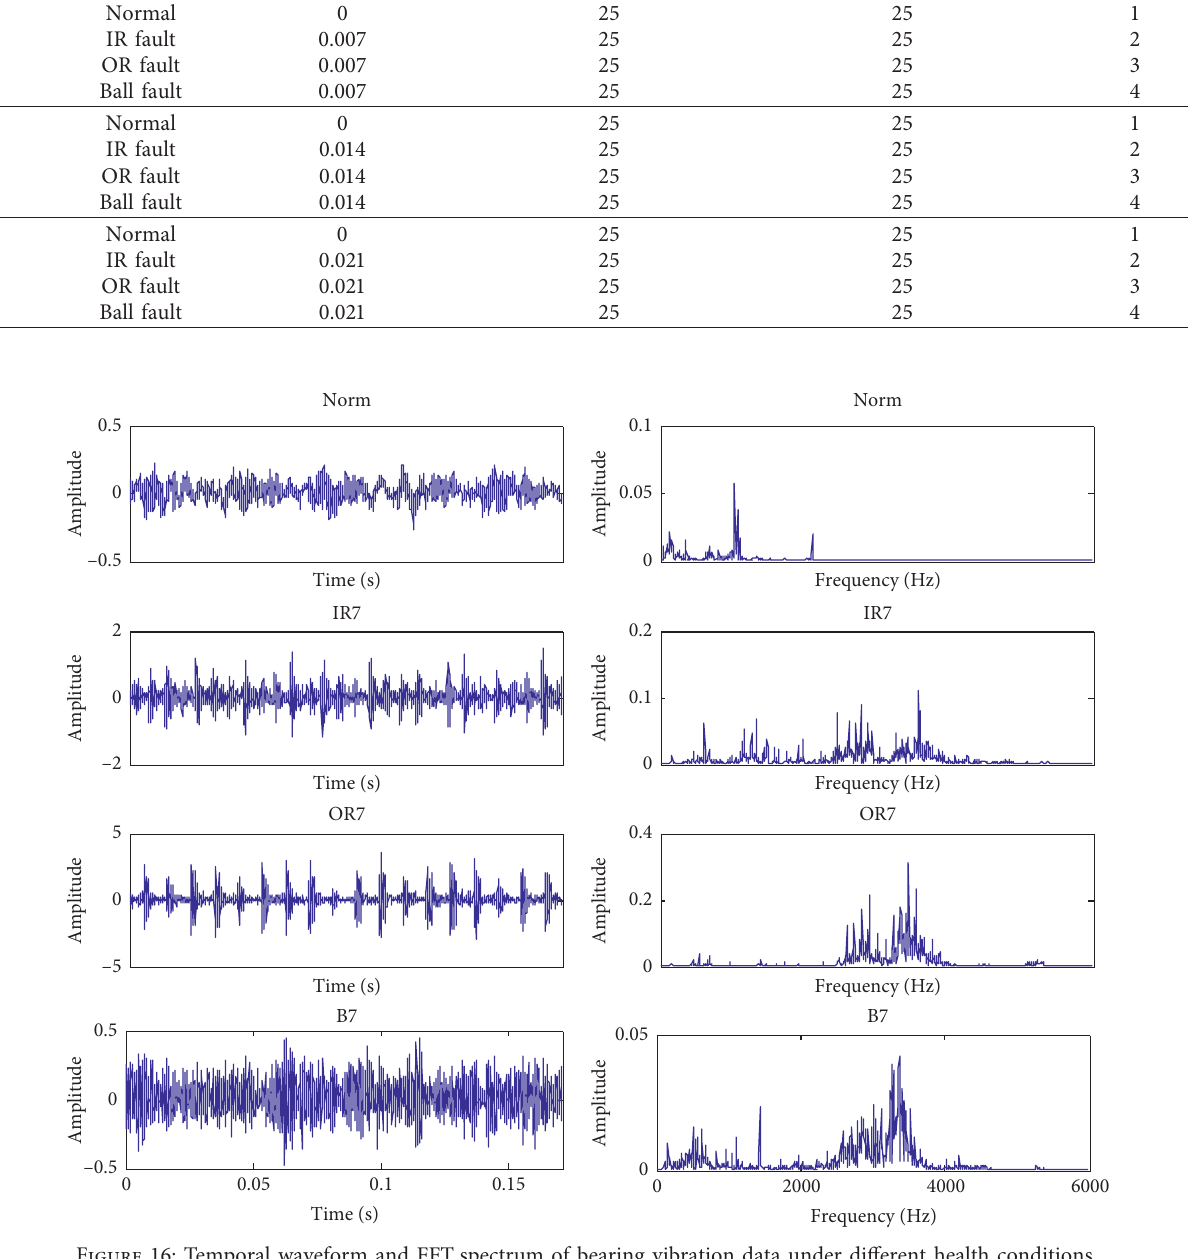
Figure 16: Temporal waveform and FFT spectrum of bearing vibration data under different health